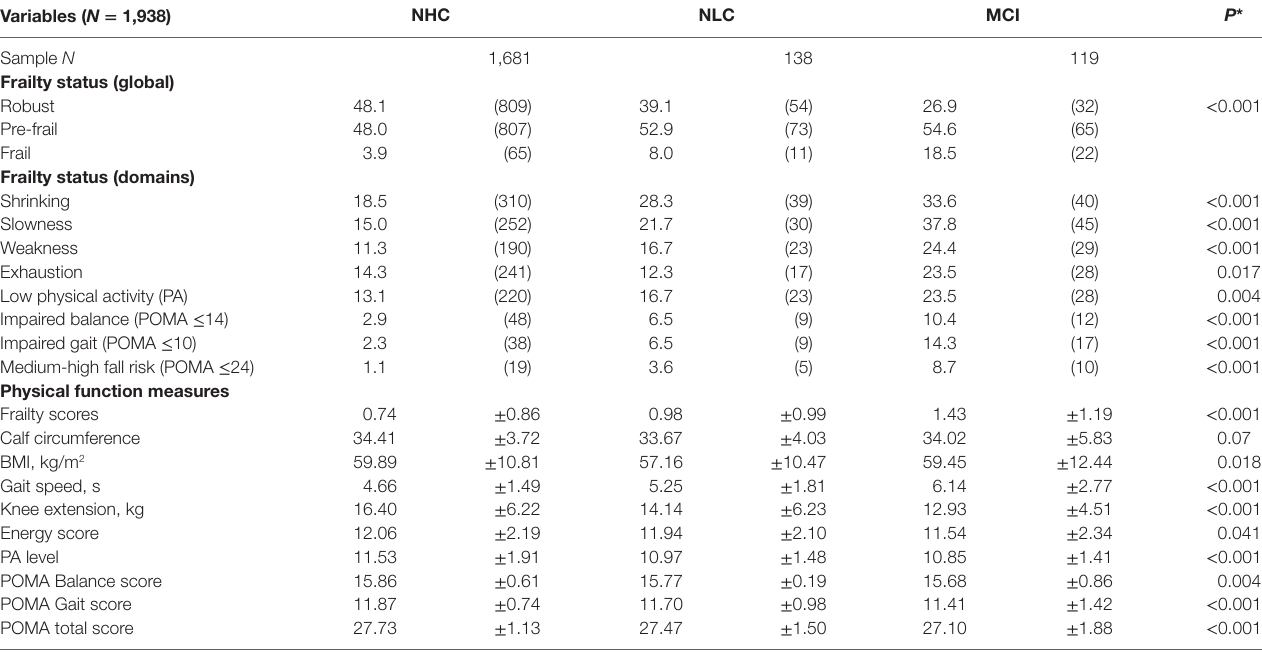
Figures are % (N) and mean ± SD. P-values of significance are derived from Chi square test for categorical variables and ANOVA for continuous variables.